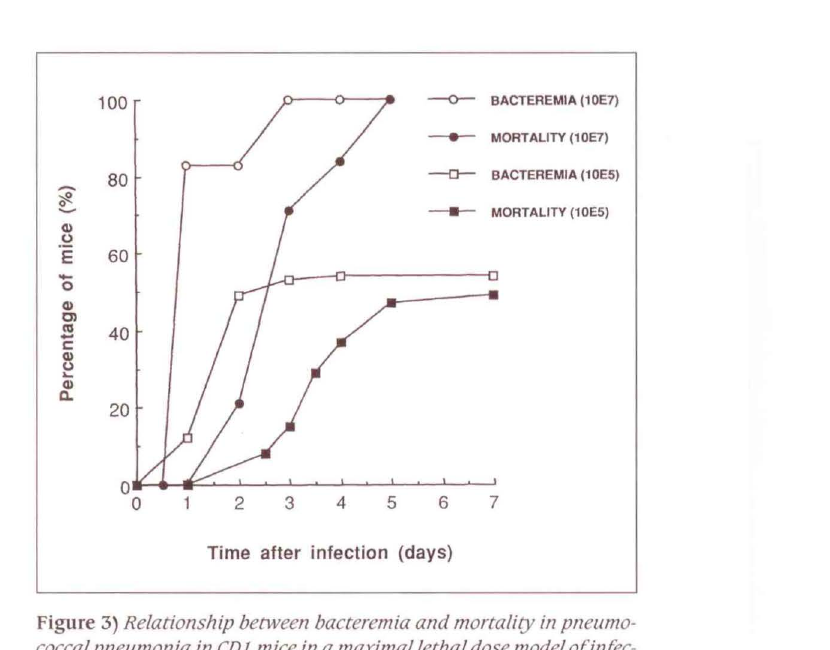
Figure 3) Relationship between bacteremia and mortality in pneumo coccal pneumonia in CD! mice in a maximal lethal dose model qfiefec tion with 10 7 bacteria per mouse and in a median lethal dose model ef iefection with 1a5 bacteria per mouse